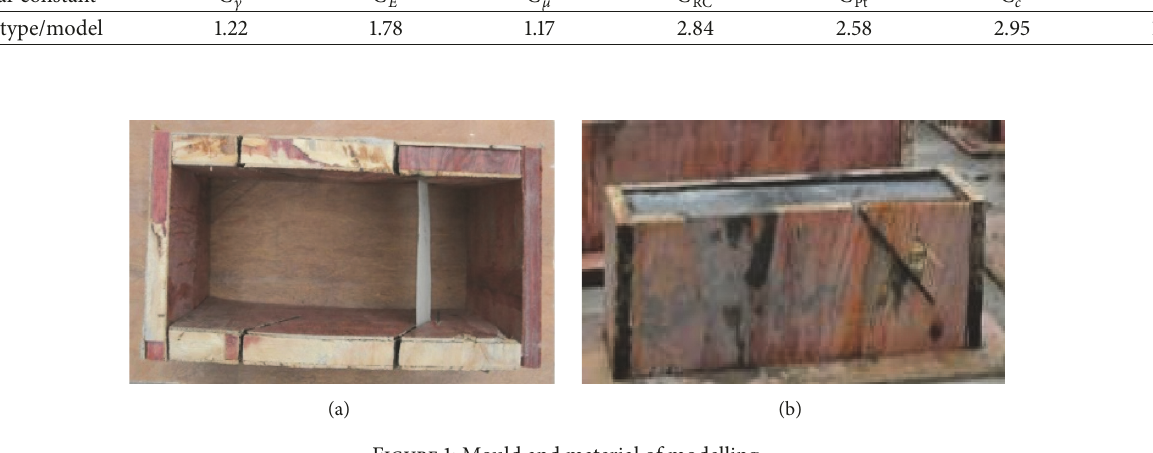
Figure 1: Mould and material of